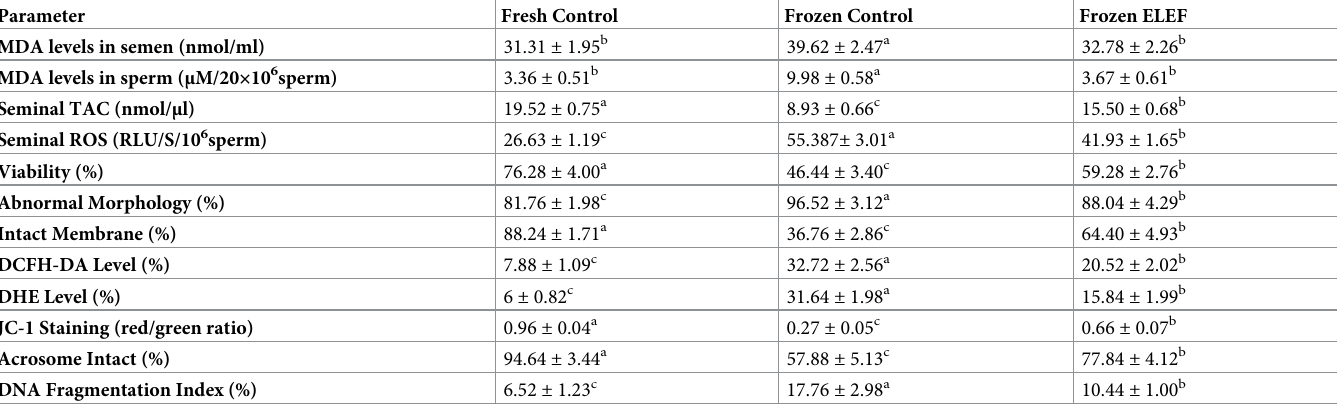
Table 3. Cellular parameters of sperm investigated between three experimental groups. The assigned letters of a, b and c indicate significant differences (p < 0.05) among the groups. Values are expressed as mean ± SD, Tukey test; n = 25. P-value Adjustment for multiple comparisons: Bonferroni.